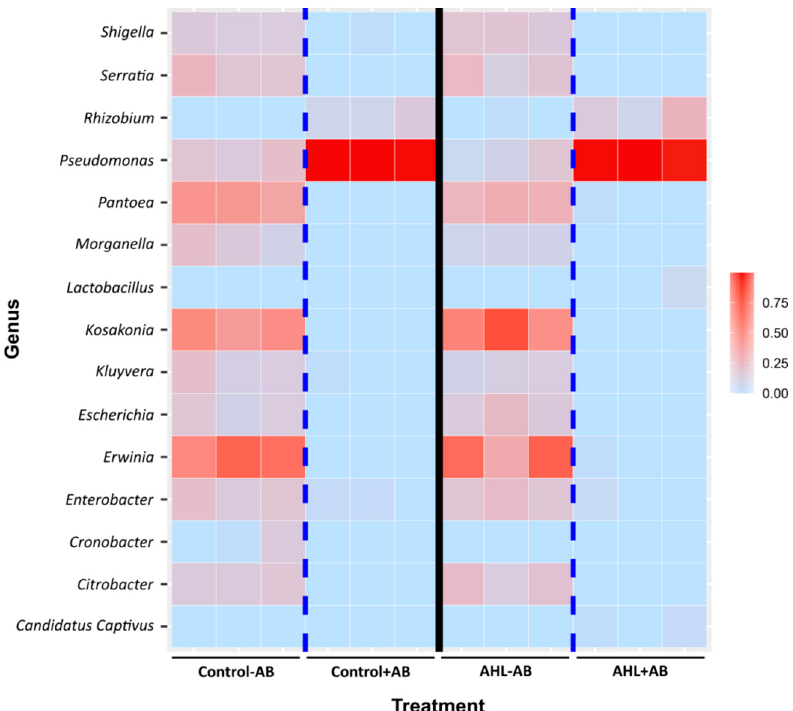
Figure 9. Heatmap of the bacterial genus composition of four-day-old Medicago roots with different treatments. The color scale shows the square root of the relative abundance. Each square represents one of the three biological replicates for each treatment. See Table S1 for the list of identified OTUs.